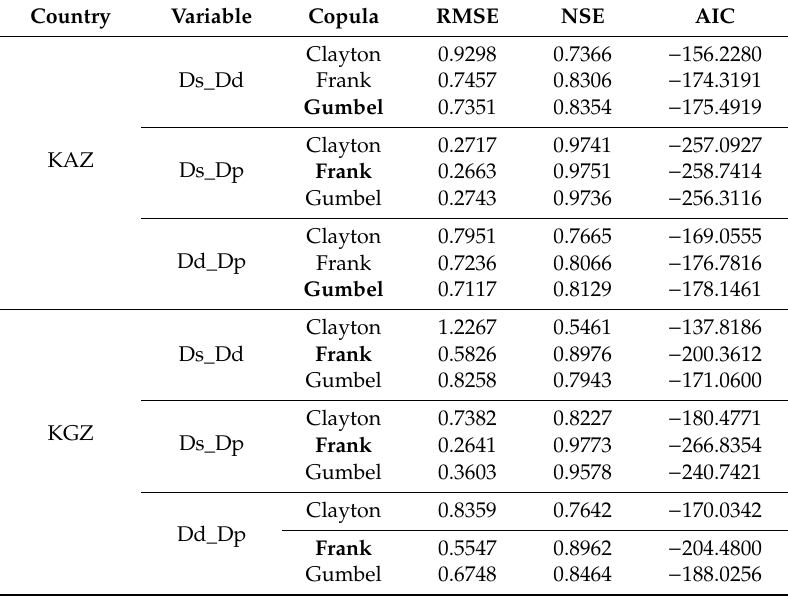
Table 5. The selection of 2D Copula